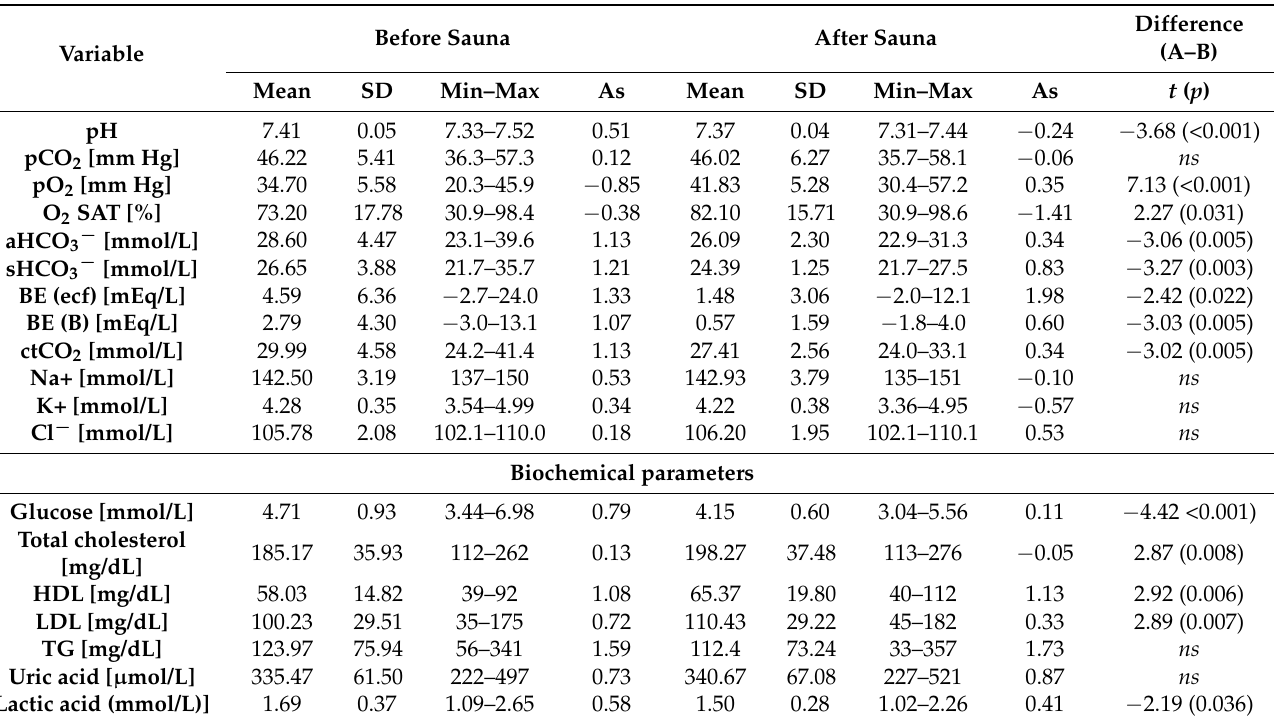
Table 4. Descriptive statistics of venous blood gasometric and biochemical parameters before and after sauna (72-ME; N =